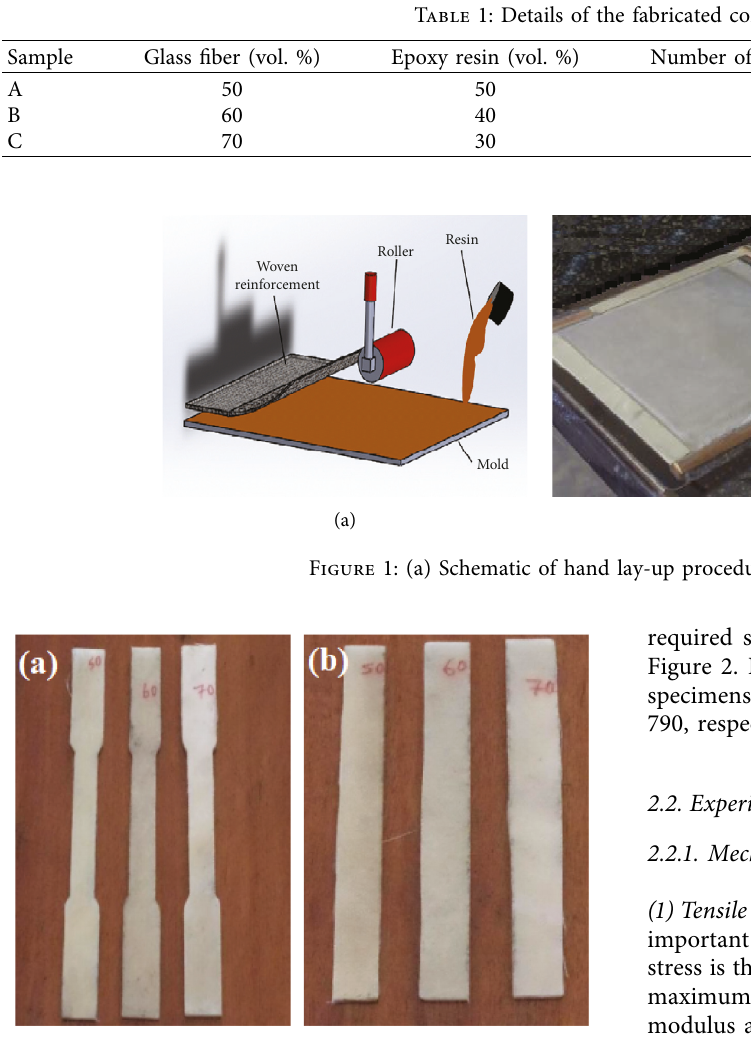
Figure 2: Composite specimens prepared for (a) tensile test and (b) flexural